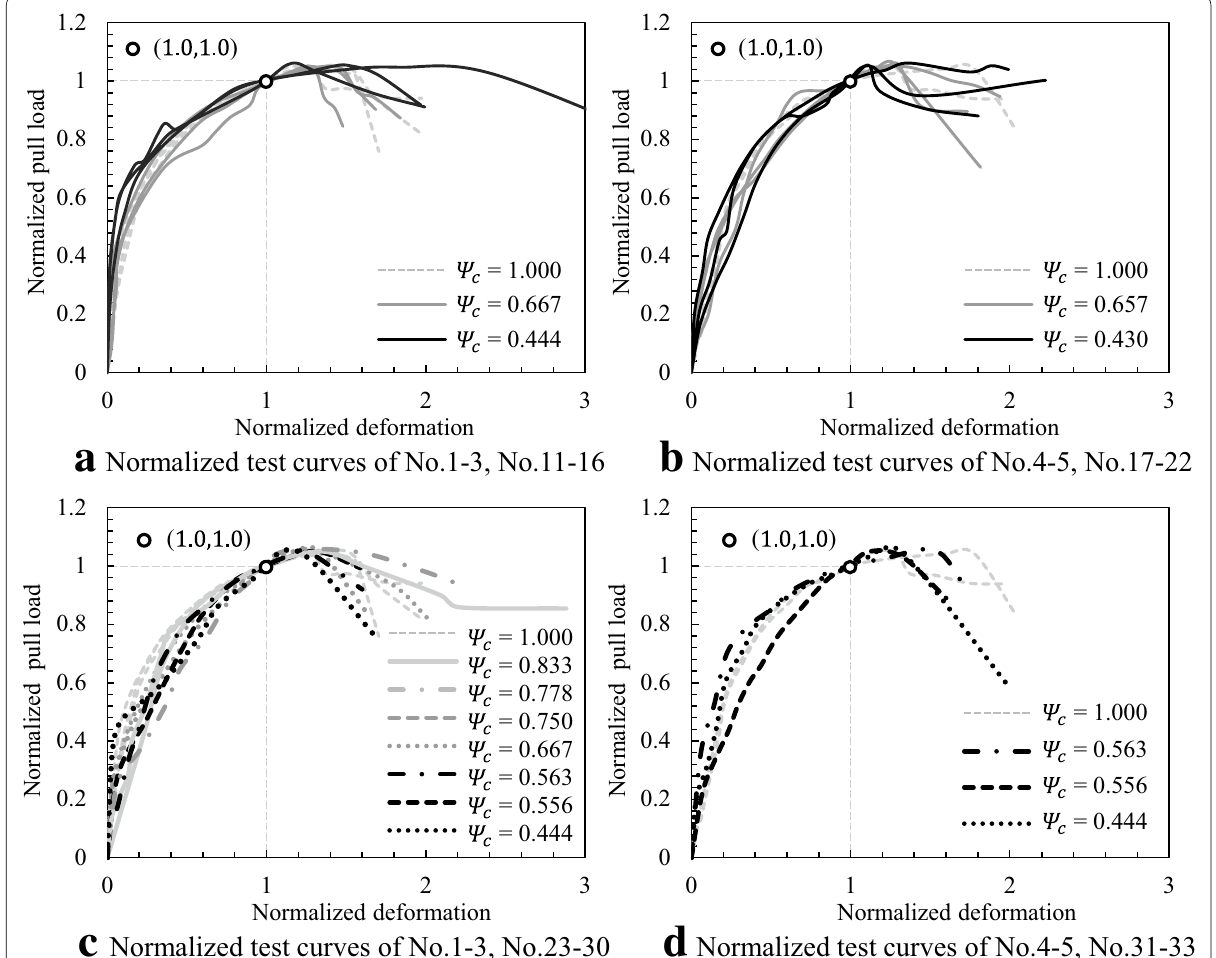
Fig. 13 Normalized load–deformation curves of the anchorage concrete with different